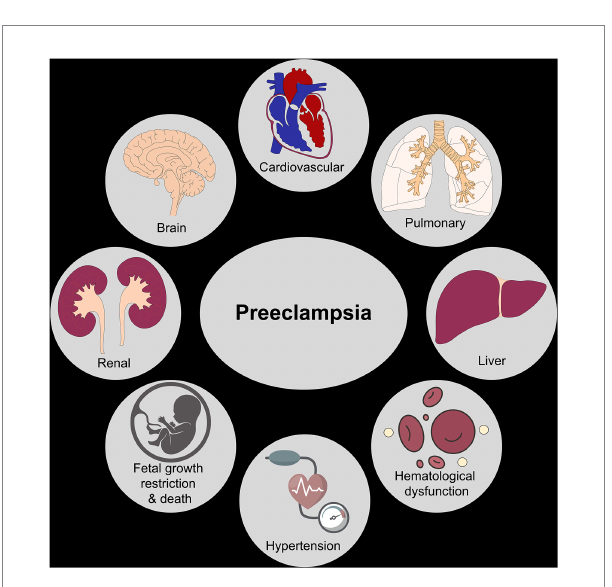
FIGURE 2 Organ systems impacted by preeclampsia. The figure shows various organ systems affected by preeclampsia leading to short-term and long-term maternal/fetal morbidity and